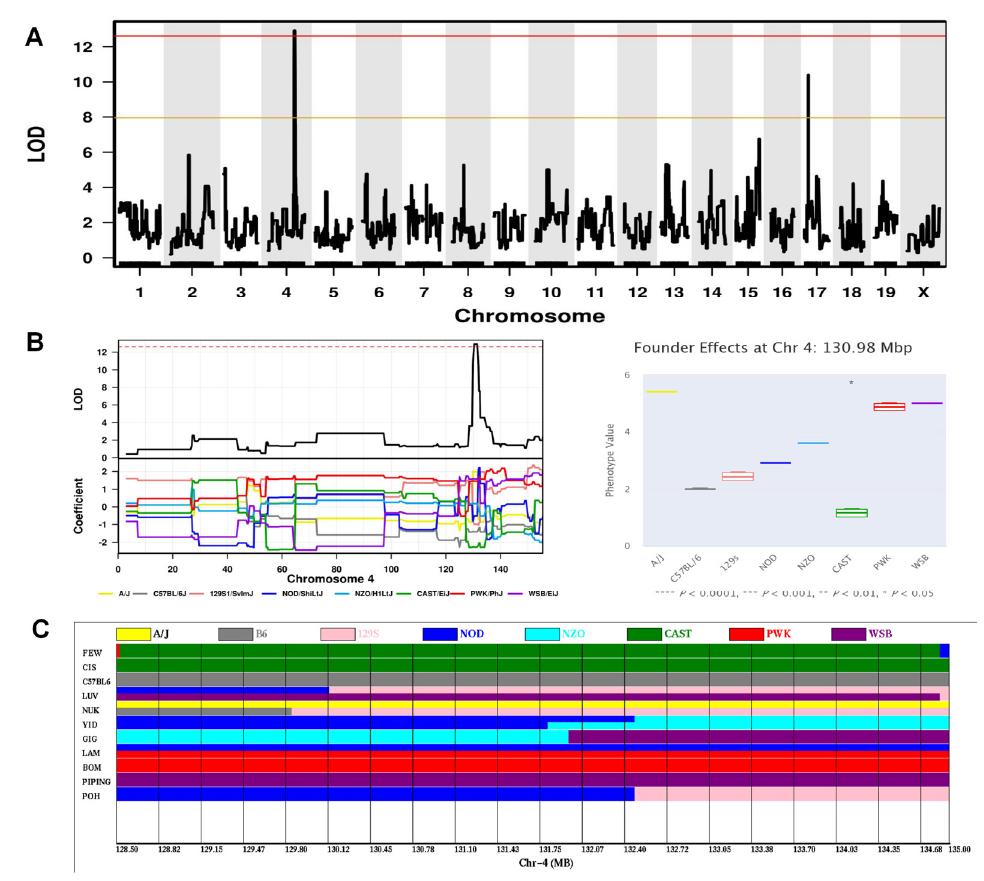
Figure 6. Mapping a significant QTL on Chr4 influencing the frequency of crossing the platform area on the probe trial phase of MWM. ( A ) Genome-wide LOD scores. The x -axis shows the chromosomal position and the y -axis shows the LOD scores. The solid red and orange horizontal lines indicate thresholds of 95% and 63% genome-wide significance, respectively. ( B ) LOD scores (upper left panel) on Chr4, and founder coefficient plot (bottom left panel) for Chr4. The dashed red horizontal line indicates thresholds of 95% significance. The association of founder haplotypes at 130.98 Mbp with this trait analyzed is shown in the right plot, indicating that the CAST haplotype significantly ( p < 0.05) associated with lowest frequency of crossing the platform area. ( C ) Founder haplotypes in all CC strains at position 128.5–135.0 Mbp on Chr4. Strains are listed in the order from lower frequency (top) to higher frequency